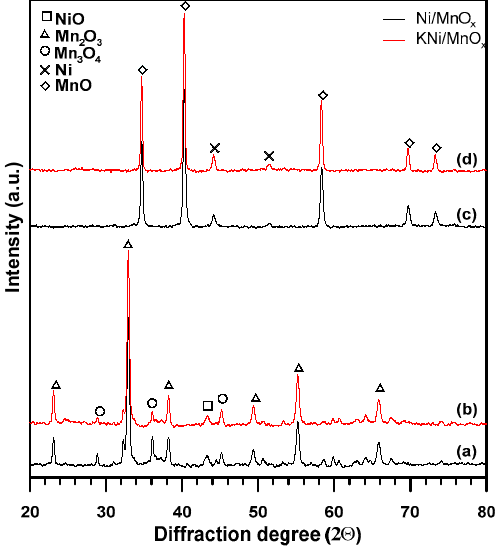
Figure 1. Microscopic analysis of the ( a ) Ni/MnO x and ( b ) KNi/MnO x catalysts after reduction at 500 °C. HRTEM images ( a 1 , a 2 , b 1 , b 2 ) and STEM-EDS analysis ( a 3 , b 3 ).